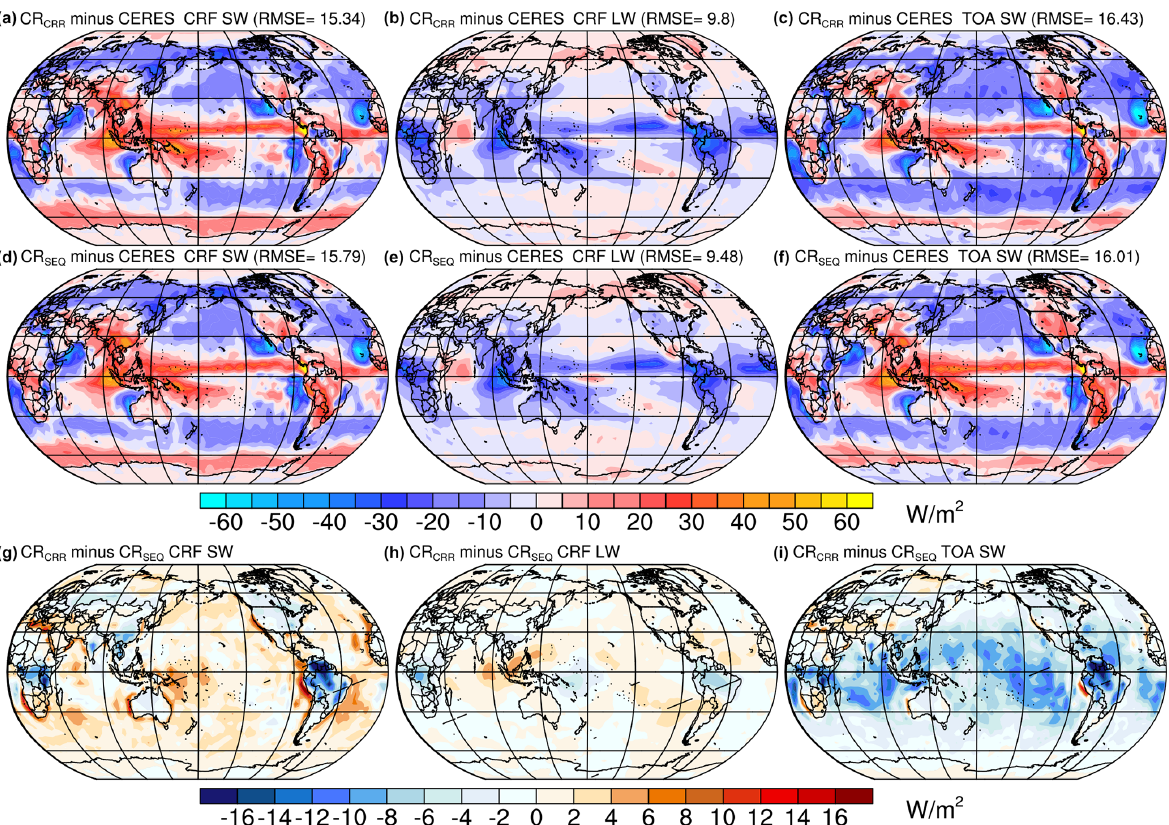
Figure 15. Annual bias in shortwave cloud radiative forcing (CRF), longwave CRF, and net shortwave radiation fluxes (Wm − 2 ) at the top of the atmosphere (TOA) in the (a, b, c) concurrent and (d, e, f) classical radiation experiments relative to data from Clouds and the Earth’s Radiant Energy System Energy Balanced and Filled product (CERES-EBAF) surface fluxes edition 4.0 for the period 2001–2013. Differences in the (g) shortwave CRF, (h) longwave CRF, and (i) net shortwave radiation at TOA between the concurrent and classical radiation scheme for the period 2001–2013. Hatching indicates significance at the 95% confidence interval using the Student’s t